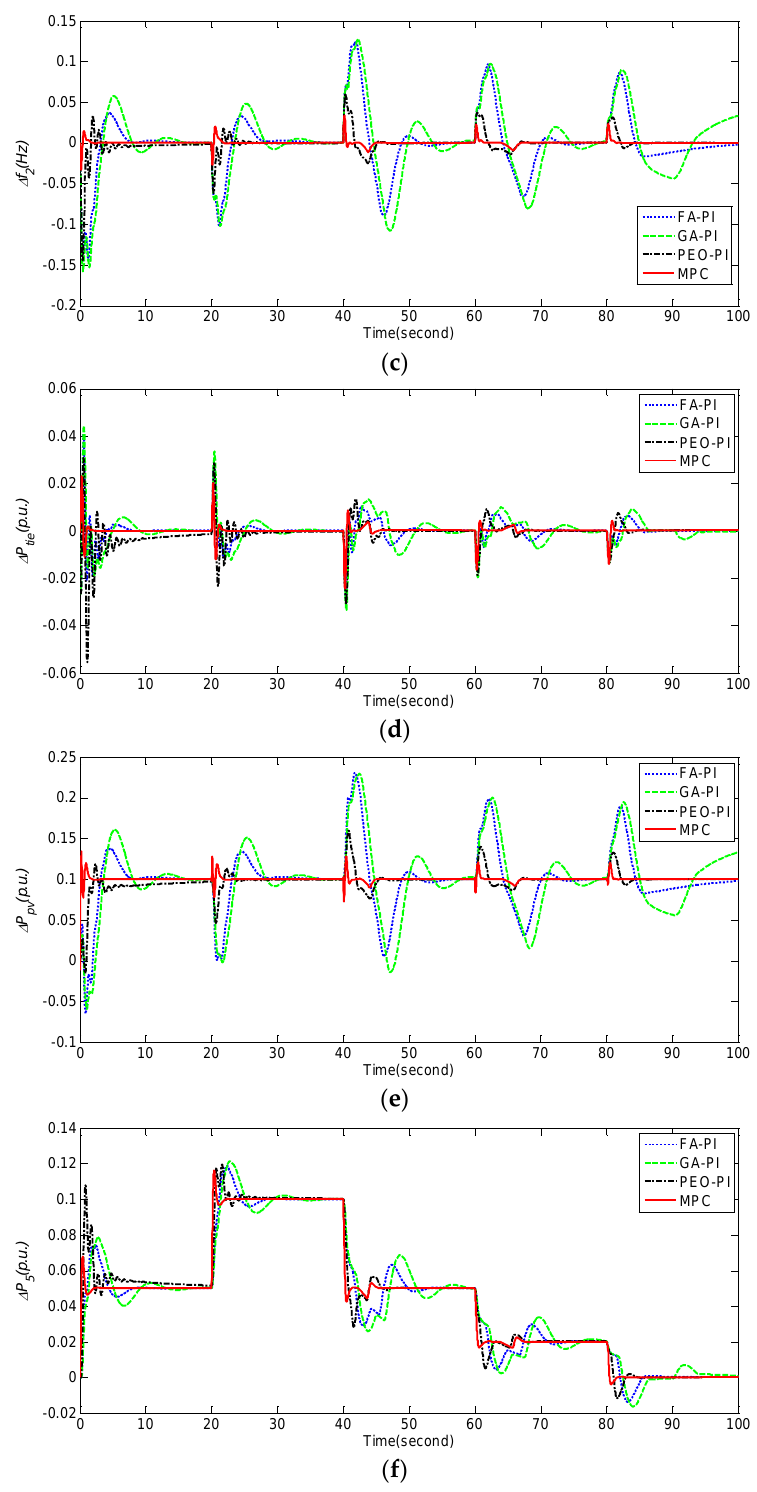
Figure 11. Comparison of frequency deviations ∆ f 1 , ∆ f 2 , and power deviations ∆ P tie , ∆ P pv , ∆ P 5 obtained by different control methods under dynamical fluctuations of ∆ P L 2 for case 6. ( a ) ∆ P L 2 ; ( b ) ∆ f 1 ; ( c ) ∆ f 2 ; ( d ) ∆ P tie ; ( e ) ∆ P pv ; ( f ) ∆ P 5 .